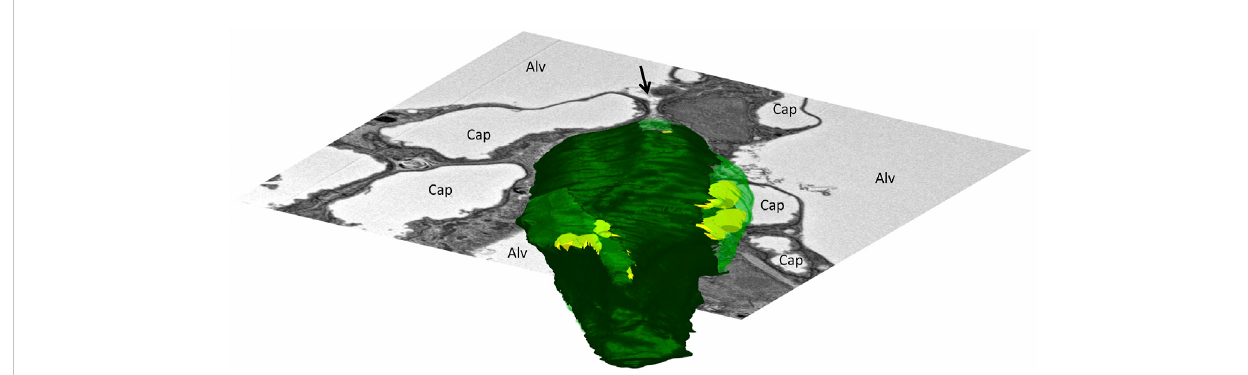
FIGURE 2 Three-dimensionalmodelofanalveolarepithelialtype2(AE2)cell:Themouselungwas fi xed insitu byvascularperfusion via therightventricleatan airwayopeningpressureof2 cmH 2 Oonexpirationaftertworecruitmentmaneuvers(3 spauseat30 cmH 2 O)(Ruhletal.,2019).Tissuewasprocessedfor serial block face scanning electron microscopy (SBF-SEM) as described in Buchacker et al., 2019. The EM image stack was used for segmentation of an AE2 cell, located within a junction of three interalveolar septa. On a three-dimensional representation of the AE2 cell surface, apical portions of the plasma membrane are shown in light green and basolateral portions that are attached to the epithelial basement membrane are shown in dark green. Lamellar bodies located below the plasma membrane are shown in yellow. The AE2 cell is, further, shown inserted into a two-dimensional electron microscopic image of the surrounding environment. The AE2 cell shows multipolarity with four apical domains being in contact with three alveolar airspaces (Alv). The arrow points into apleat fi lled with protein containing fl uid(hypophase). Thebottom ofthepleat isformedinpartby one oftheapical domains of the AE2